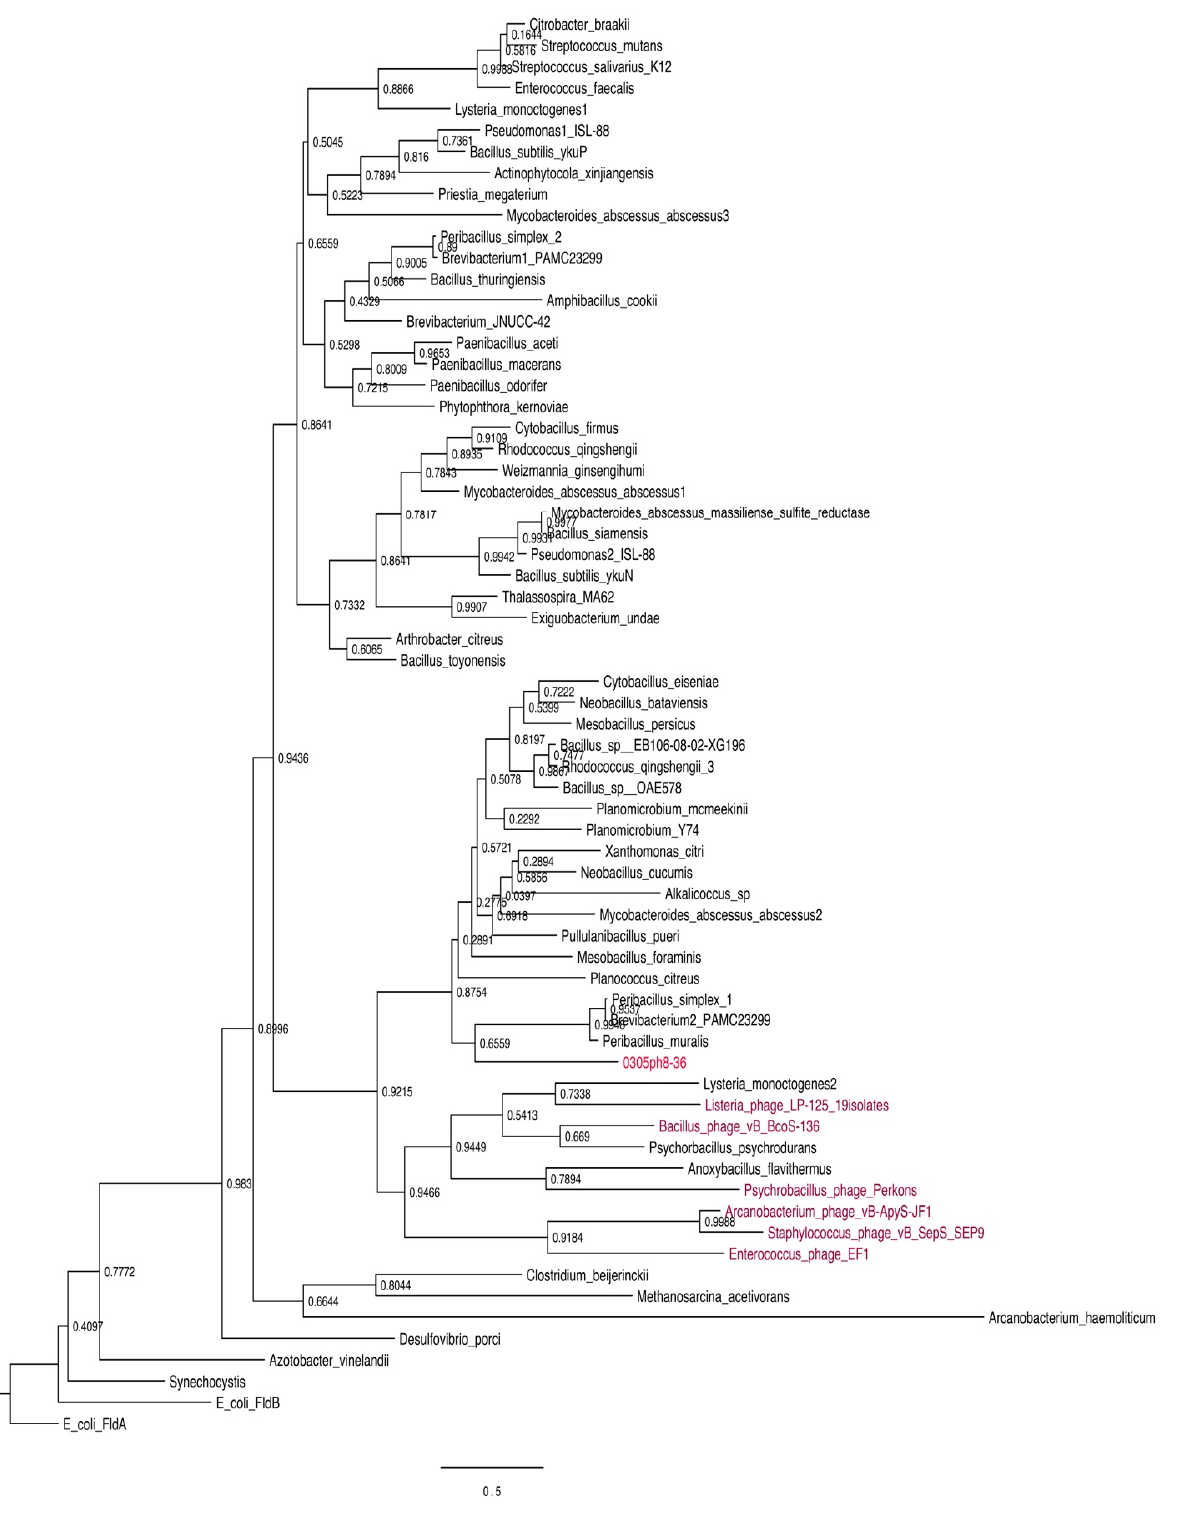
Figure 3. Relationship of 0305 φ 8-36 flavodoxin with other phage and bacterial host flavodoxins. Phylogenetic tree of 0305 φ 8-36 flavodoxin with additional phage flavodoxins and the respective hosts of most of the phages with flavodoxins. Numbers indicate the bootstrap probability values for the branch topology